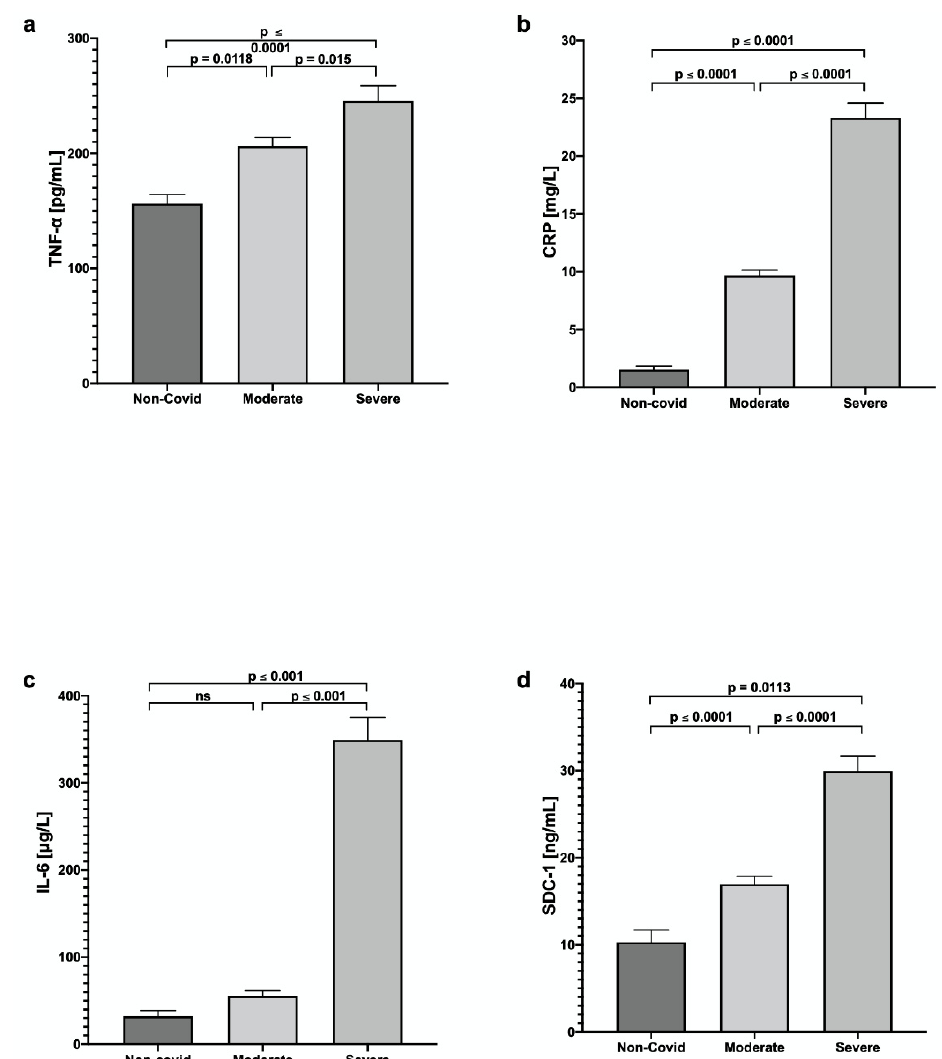
Figure 2. Analysis of the systemic inflammatory state of patients with moderate and severe COVID-19 vs. control: ( a ) Tumor Necrosis Factor-alpha (TNF- α ), ( b ) C-Reactive Protein (CRP), ( c ) Interleukin 6 (IL-6), and ( d ) Syndecan-1 (SDC-1). Values are expressed as mean ± SE.